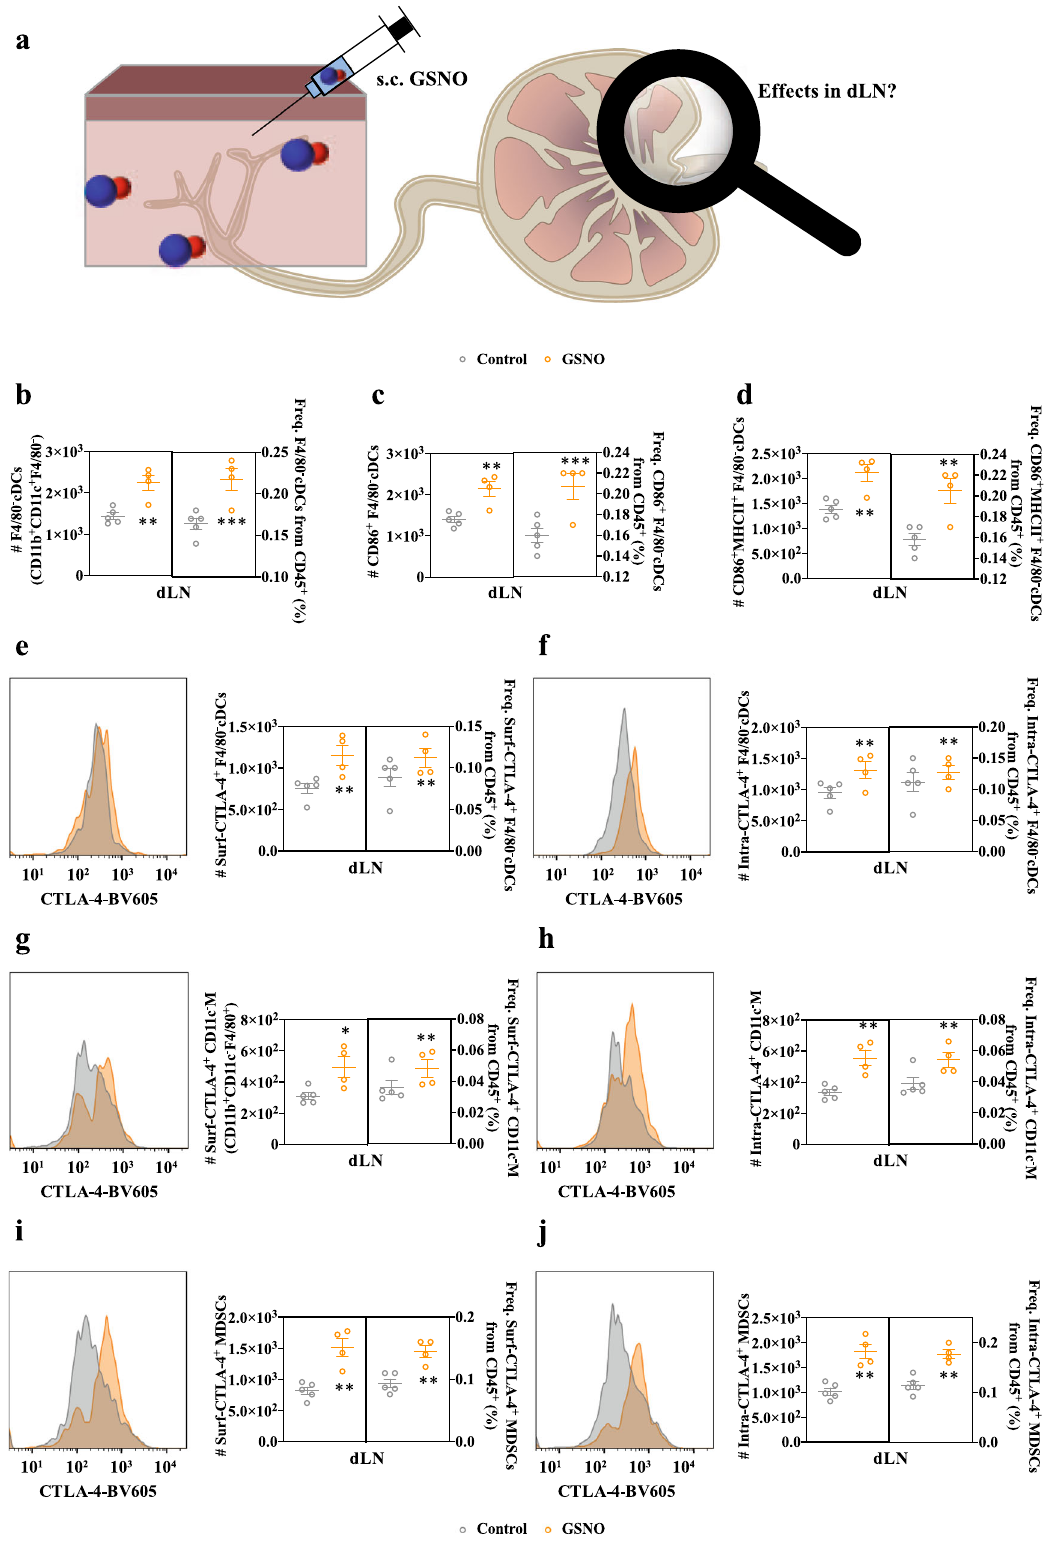
frequencies of Ki-67 + CD45 − cells (Fig. 2h). These results imply that i.t. administration of GSNO may have protumoral effects that are immune-mediated, including but not limited to tumor cell immunogenicity or by expanding tolerogenic immune cells that foster immunosuppressive tumor microenvironments. How- ever, except for expression of PD-1 by CD45 − cells in the